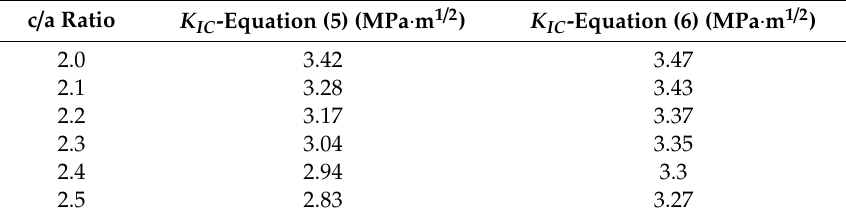
Figure 10. The SEM morphology with a normal force of 0.2 N. Table 4. The fracture toughness of SiC according to di ff erent c / a ratios.